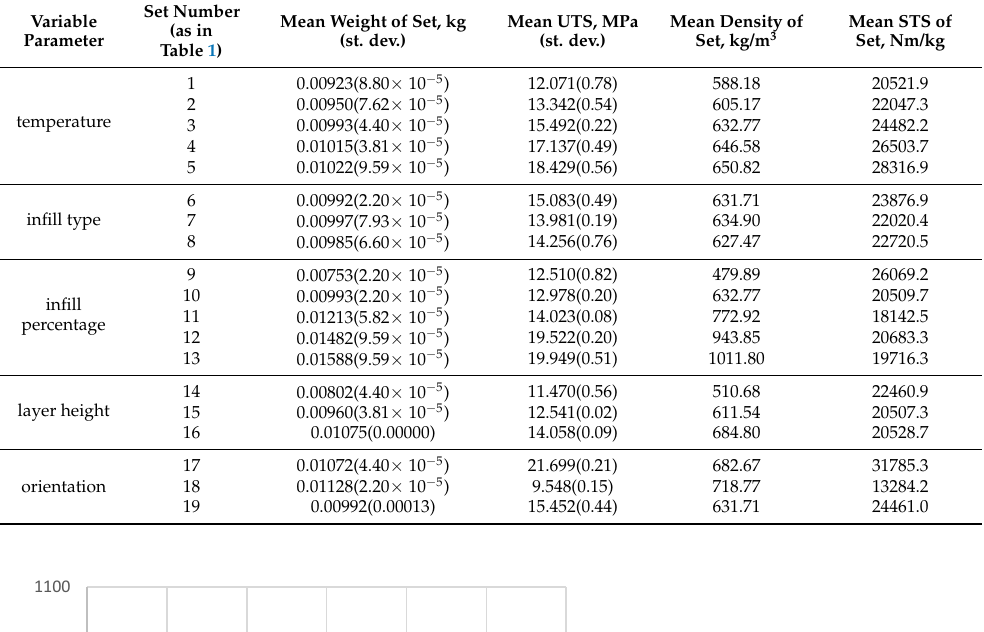
Table 3. Test results for PLA material.